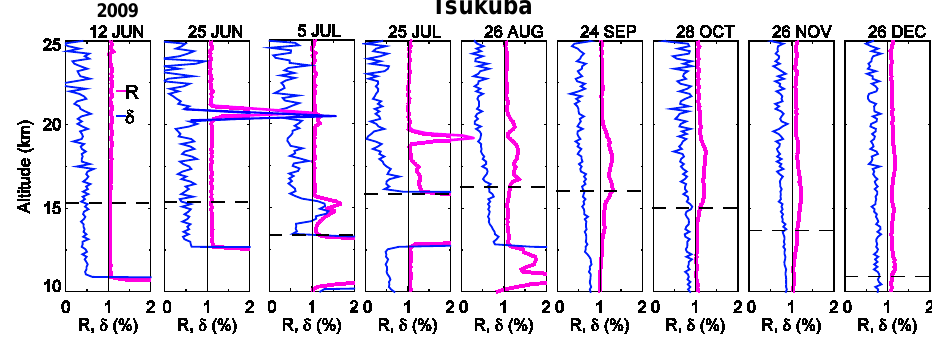
Fig. 7. Profiles similar to Fig. 1 over Tsukuba from June to December 2009 after the 2009 Sarychev eruption.